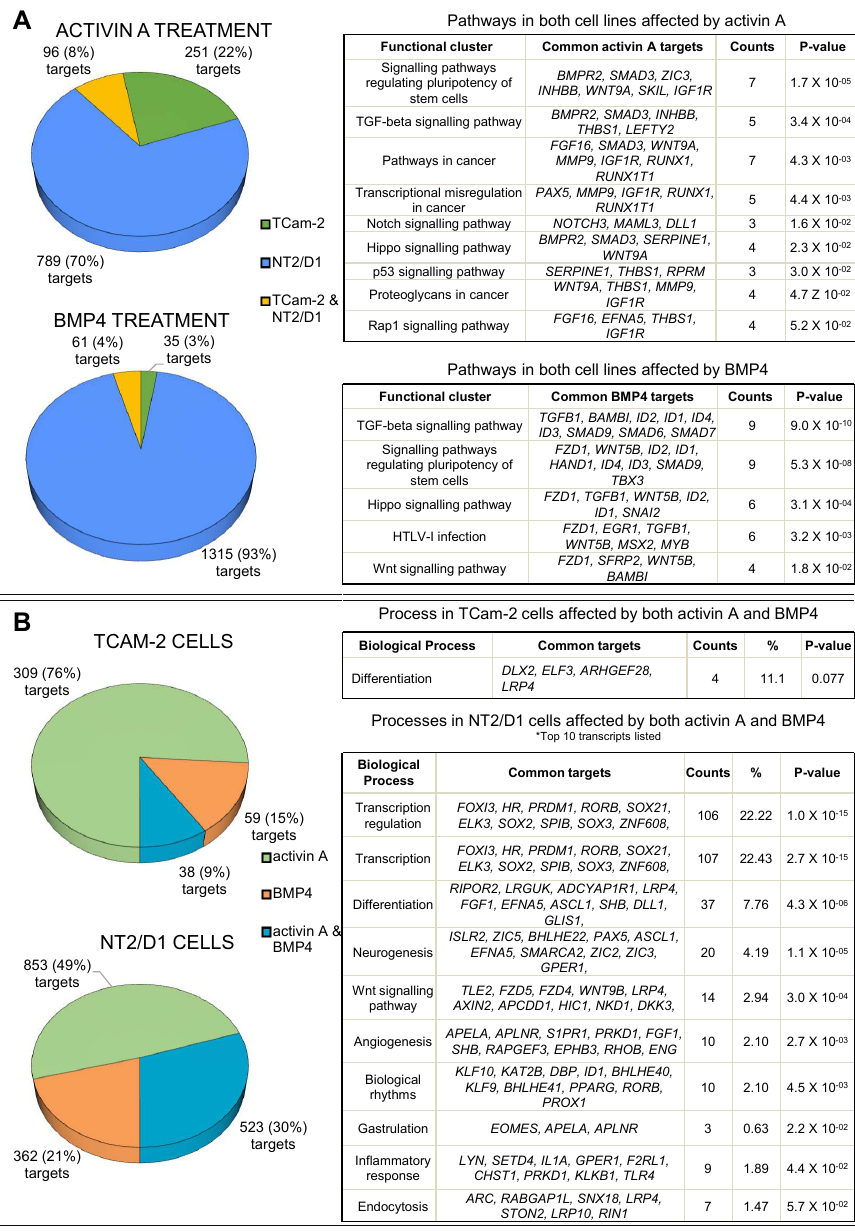
Figure 2. RNA-seq analyses of activin A- and BMP4-treated TCam-2 and NT2/D1 cells. ( A ): Tran- script levels changes in TCam-2 cells (347 significantly different) and NT2/D1 cells (885) resulting from 6 h of 5 ng/mL activin A exposure identified in RNA-seq data, with 96 transcripts altered in both cell lines. Significant transcript level changes in TCam-2 cells (96) and NT2/D1 cells (1376) were identified after 6 h of 5 ng/mL BMP4 exposure, with 35 transcripts altered in both. ( B ): Common transcripts affected by both activin A and BMP4 in TCam-2 cells (38) and NT2/D1 cells (523). The KEGG pathway analysis of these common differentially expressed genes used the DAVID online tool, with FDR cut-off set at 0.1. Supplementary Tables S1 and S2 contain the full DAVID analysis of the differentially expressed genes and the signalling pathways affected,